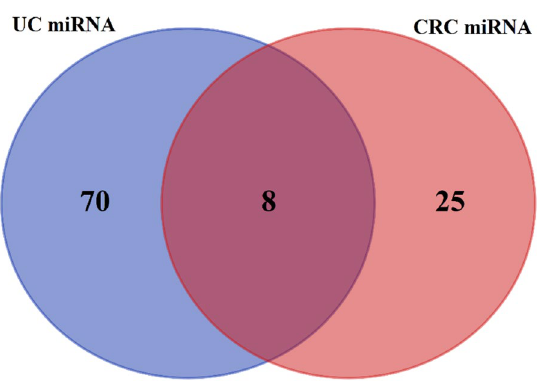
Figure 4. VENN diagram between miRNA datasets related to CRC and UC. The VENN diagram between the two data sets related to miRNA CRC and miRNA UC, finally 8, common miRNA DE were